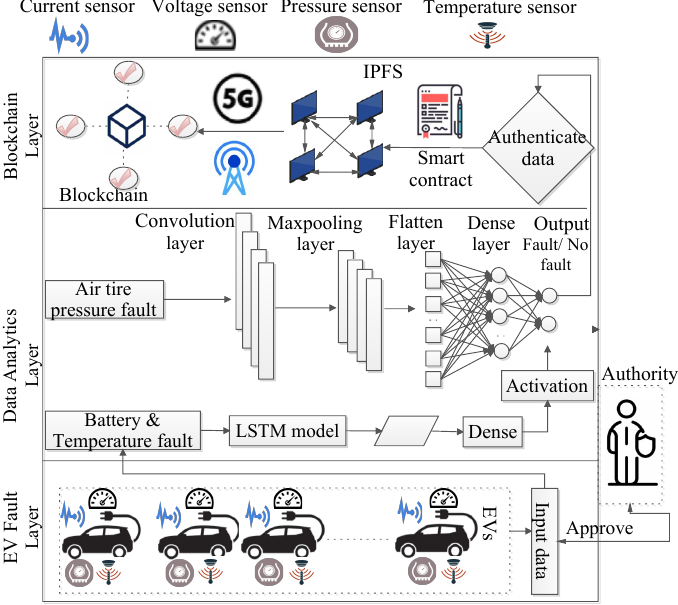
Figure 2. The proposed fault detection